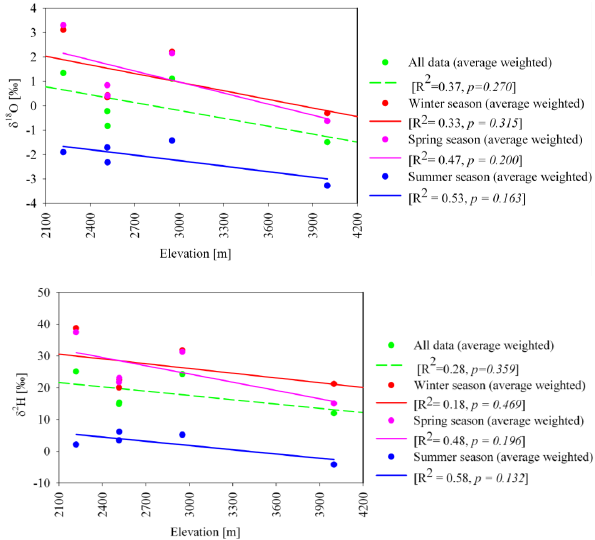
Figure 5. Relationships between average and seasonal amount Fig. 5. Relationships between average and seasonal amount weighted isotopic composition weighted isotopic composition of precipitation with elevation at five of precipitation with elevation at five precipitation sampling stations. precipitation sampling stations.